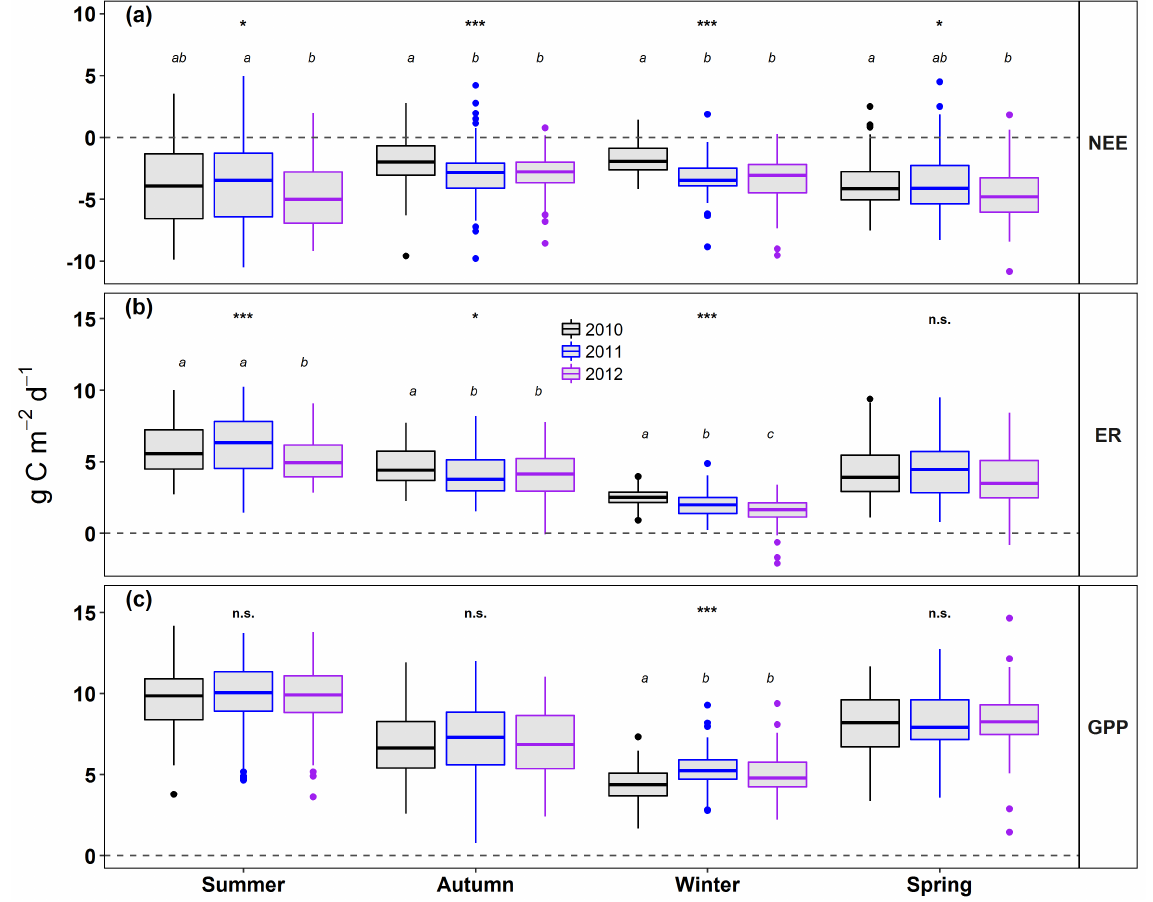
Figure 4. Box-and-whisker plots of daily averages of (a) NEE, (b) ER and (c) GPP for years and seasons; inter-annual differences are displayed for each season with p values (significance level p <0.05); letters indicate year-to-year differences.